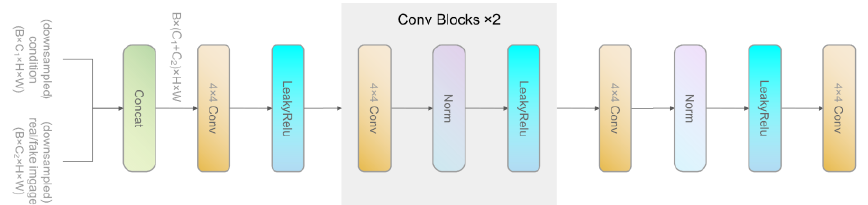
Figure 7. The architecture of a single discriminator. All discriminators in {𝐷 1 , 𝐷 2 , 𝐷 3 } share this architecture. The input is downsampled by factors of 2 and 4, then fed to 𝐷 2 and 𝐷 3 , respectively, while 𝐷 1 takes the original image as input.